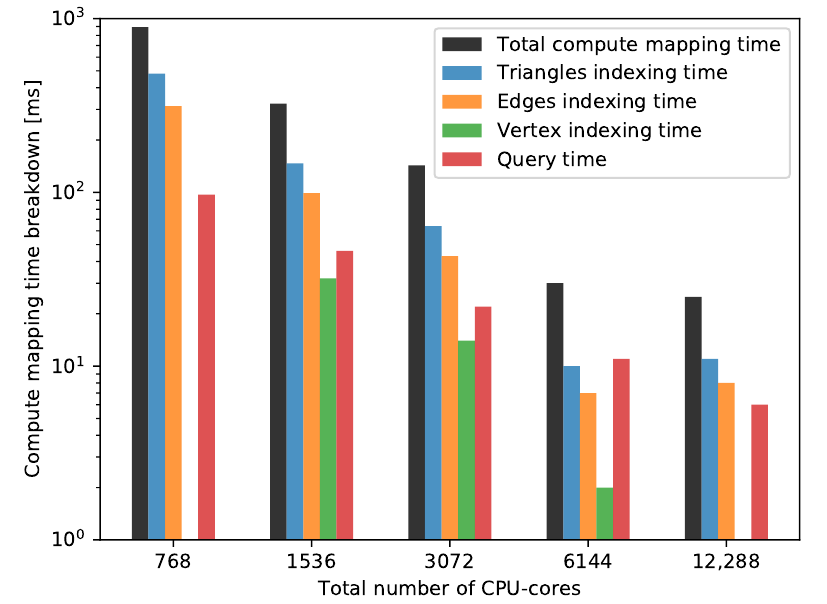
Figure 12. Strong scalability measurements: Breakdown of the mapping computation time of the two-level approach. The mapping projects vertices from mesh M5 onto connectivity information of mesh